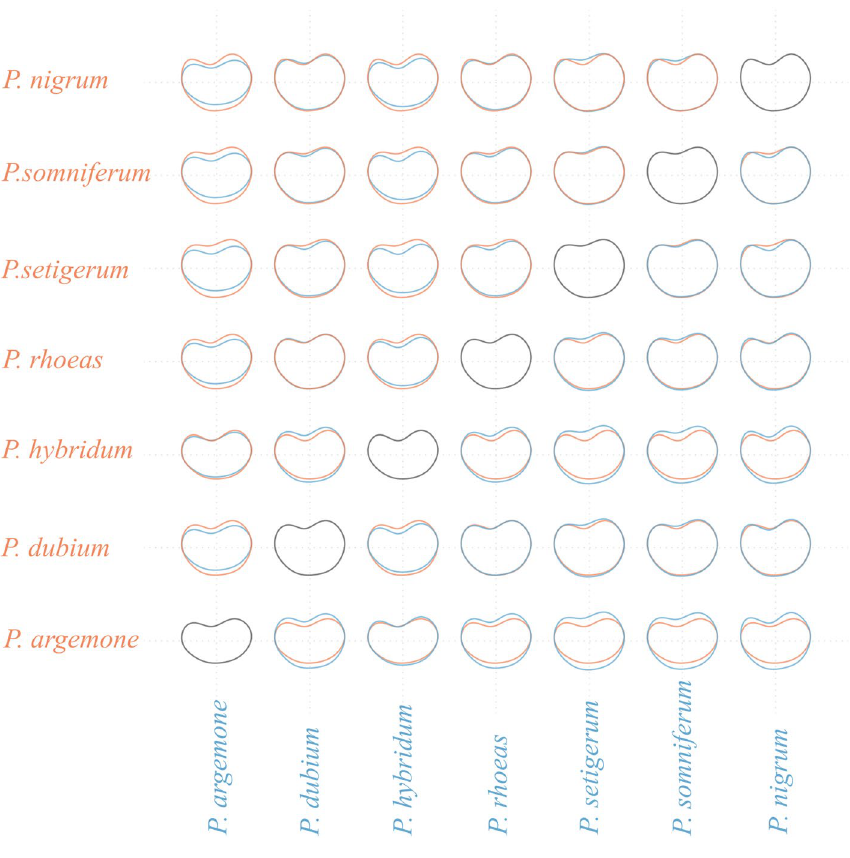
Figure 4. Mean shapes pairwise comparisons for all Papaver taxa studied here. Orange colour corresponds to the taxon of the rows and the blue colour to the taxon of the columns.